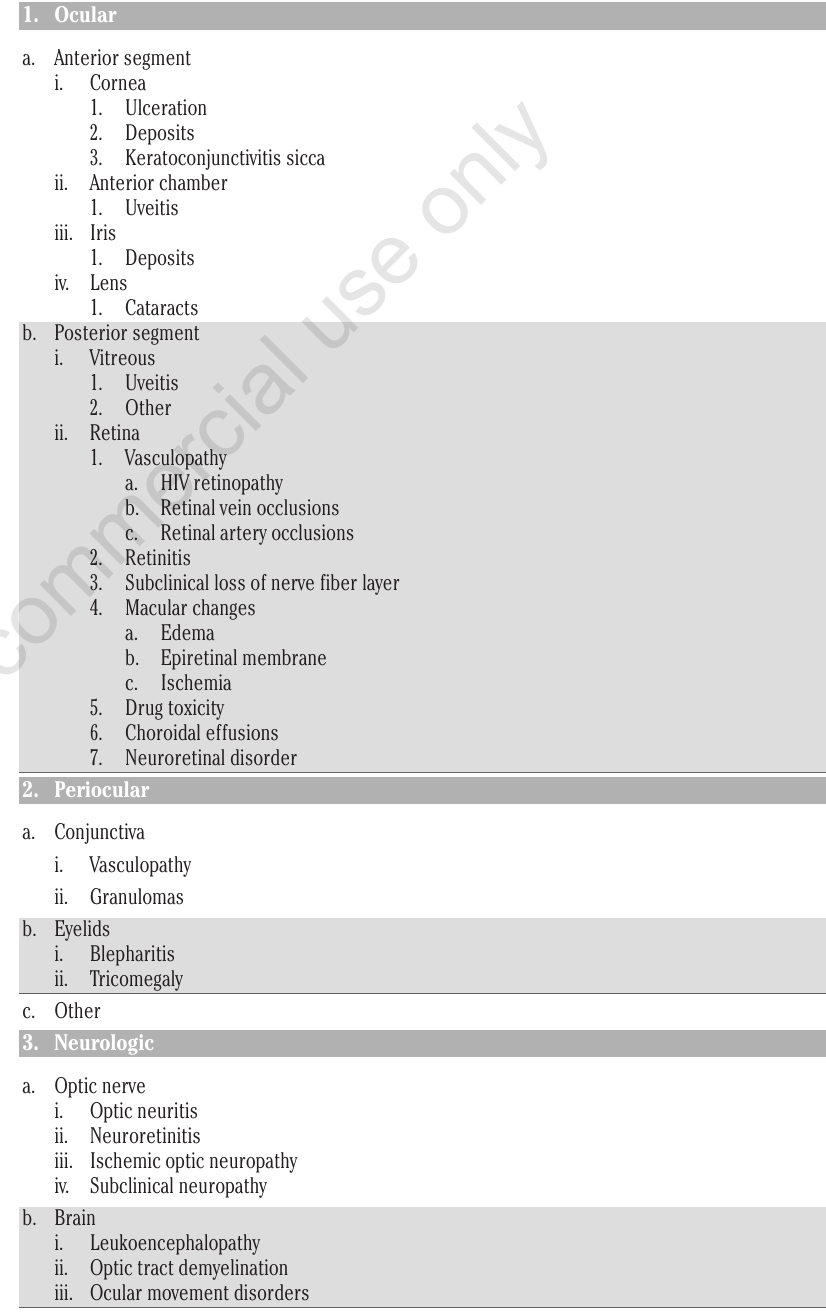
Table 1. HIV related lesions of the visual system are listed by